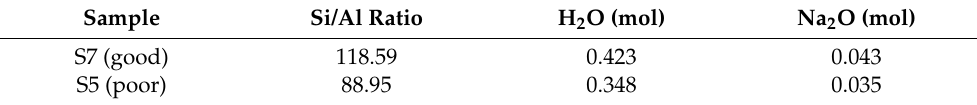
Table 9. Difference in Si/Al ratio, H 2 O and Na 2 O content of samples S7 and S5 after fire-retardant test.